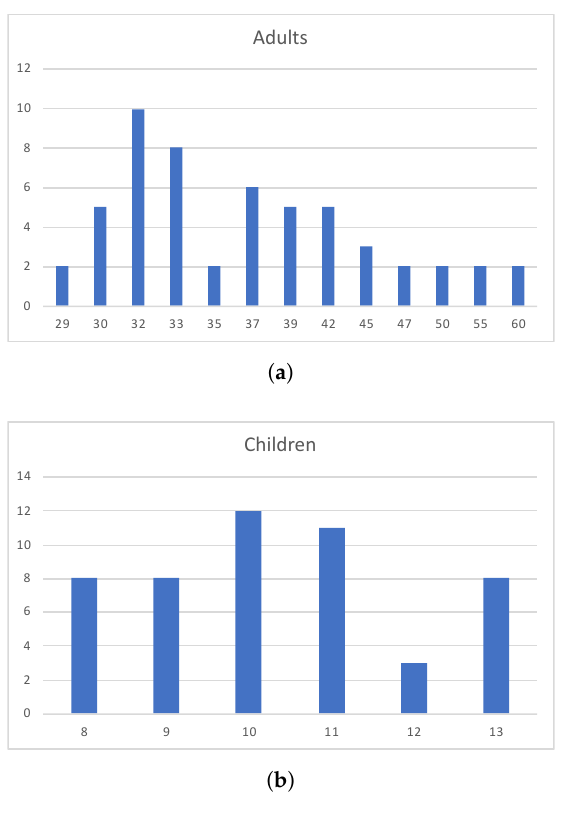
Figure 3. The graphs in this figure represent the age of the people that are involved in the dataset collection. On the horizontal axis there are the ages of the people and on the vertical axis there are the numbers of the people for each age. ( a ) reports the statistics for Adults, ( b ) for children.